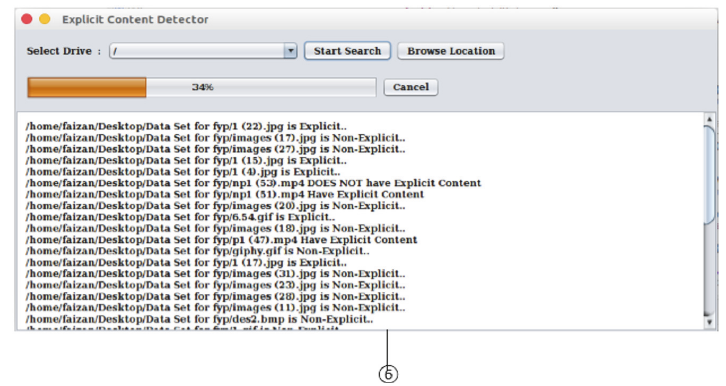
Figure 10: Scanning progress of explicit/nonexplicit content from the selected drive/folder.